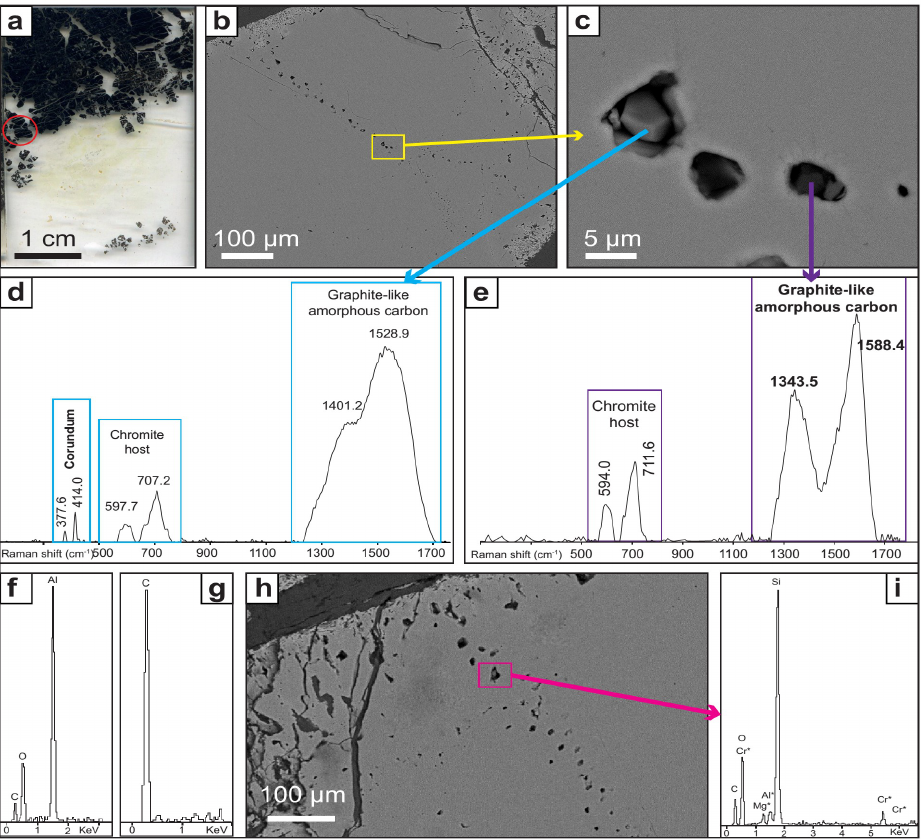
Figure 6. Inclusion trails in chromite grains: ( a ) Thin section containing the inclusion trails in images ( b , c ). The location of the inclusions in the section is shown with a red circle; ( b ) Backscattered electron (BSE) image of a trail of inclusions; ( c ) Detail of three inclusions hosting corundum and graphite‐like amorphous carbon, BSE image. ( d ) Raman spectra of corundum, the host chromite and graphite‐like amorphous carbon surrounding the corundum crystal; ( e ) Raman spectra of the carbon‐bearing inclusion in image ( c ), showing the host chromite and graphite‐like amorphous carbon; ( f ) Energy‐Dispersive Spectroscopy (EDS) spectra of the corundum crystal of image ( d ), showing qualitatively its chemical composition; ( g ) Energy‐Dispersive Spectroscopy (EDS) spectra of the carbon‐bearing inclusion in image ( c ); ( h ) BSE image of inclusion trail close to the chromite alteration rim; ( i ) Energy‐Dispersive Spectroscopy (EDS) spectra of the SiO 2 crystal of image ( h ), showing qualitatively its chemical composition.